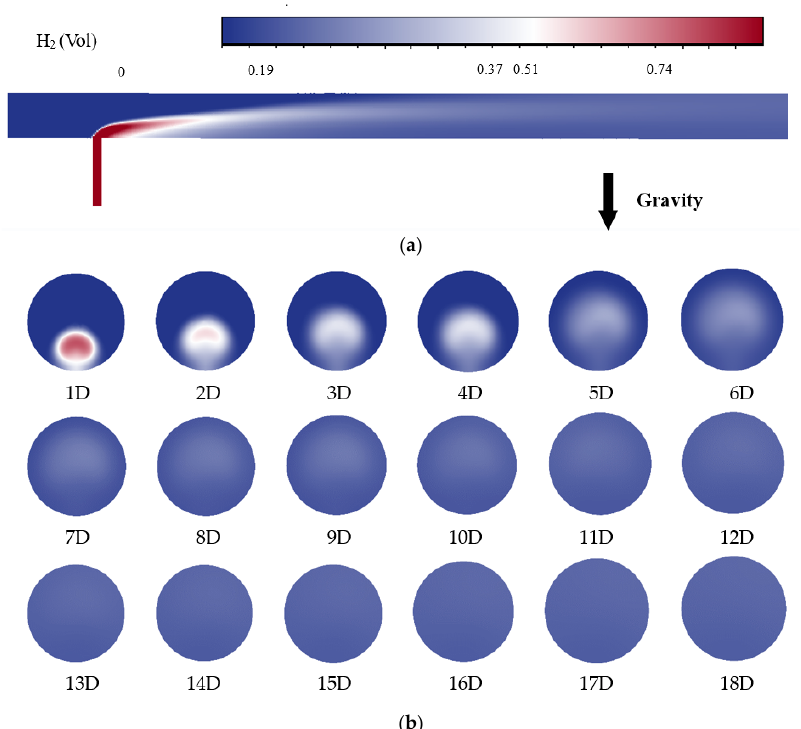
1m/s v = , = 1 m/s, 4 CH 4